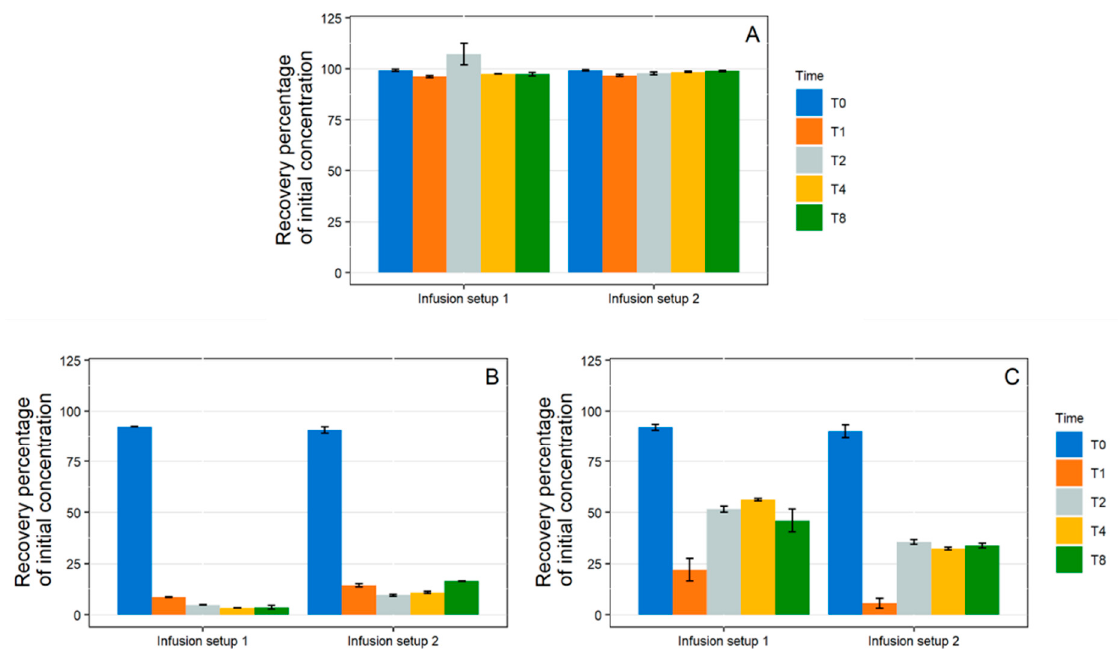
Figure 6. Evolution of the recovered percentage of initial concentration in paracetamol ( A ), diazepam ( B ), and insulin ( C ) in 1 mL/h dynamic condition with both complete infusion setup (setup 1: polypropylene syringe + polyvinyl chloride extension set + Turbo-Flo polyurethane catheter. Setup 2: polypropylene syringe + polyethylene coextruded with polyvinyl chloride extension set + Turbo-Flo polyurethane catheter ( n = 3, mean ± standard error of the mean). T0–T8: different analysis times: immediately after purging (T0), then after 1 h (T1), 2 h (T2), 4 h (T4), and 8 h (T8) of infusion.